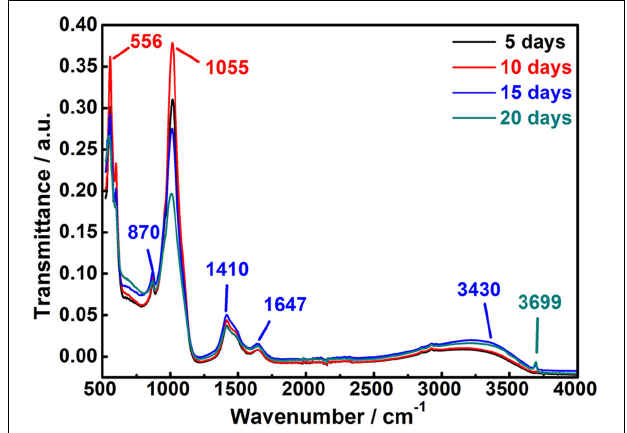
FIGURE 8 | FT-IR of MAO-ED coating samples after different immersion